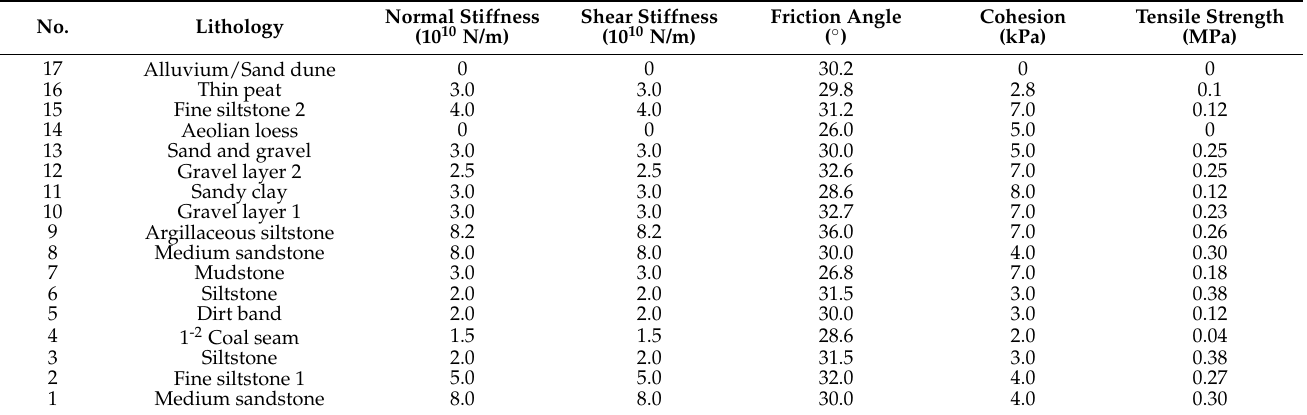
Table 2. Mechanical and physical properties of the